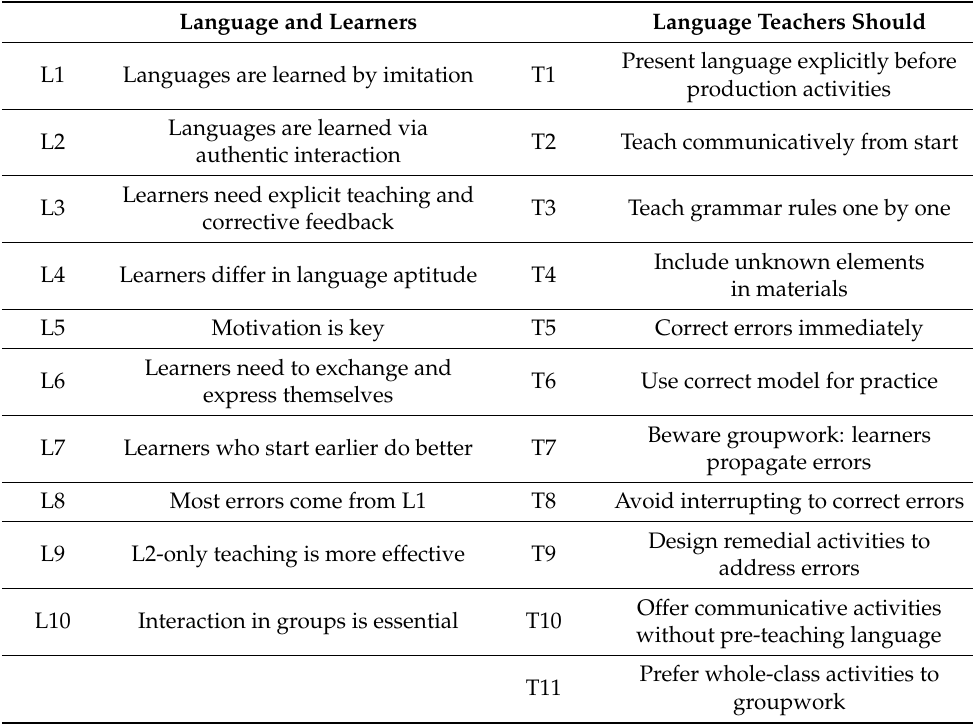
Table 2. Summary of teaching and learning items (adapted from Lightbown and Spada 2013). Language and Learners Language Teachers